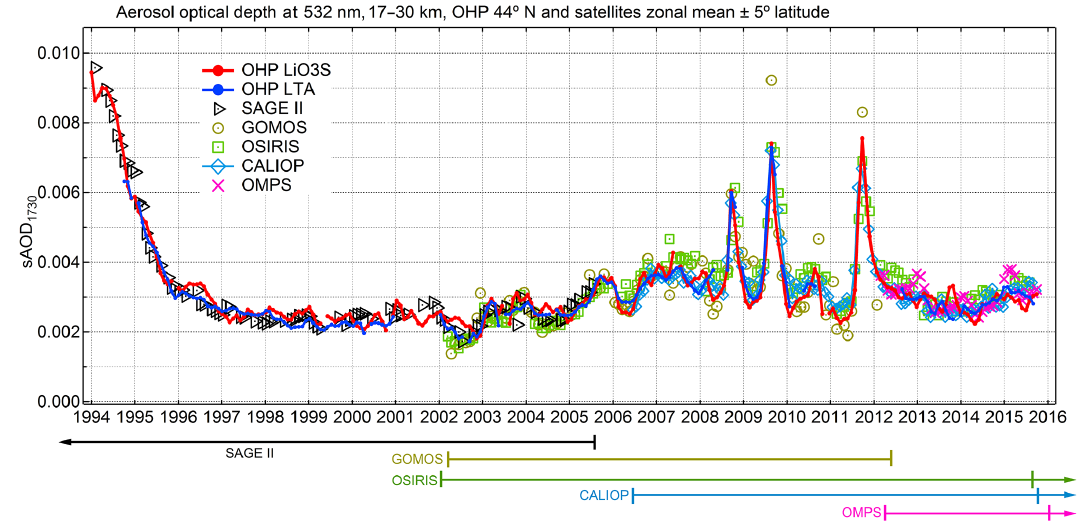
Figure 1. Time series of monthly mean sAOD 1730 from OHP lidars and monthly and zonal mean sAOD 1730 within 40–50 ◦ N from satellite sounders. Time spans and data availability of satellite missions are shown below the panel (see Table 1 for additional information). Table 1. Stratospheric aerosol sensors exploited (columns, left to right): name of instrument, operating wavelength, wavelength exponent for extinction κe used for conversion to 532nm, conversion factor (see Eq. 3), time span of available data. Instrument Wavelength, λ 1 W. exponent,